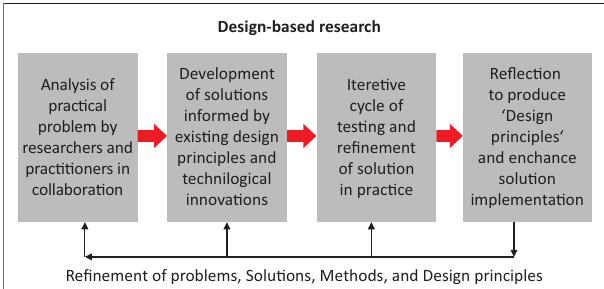
FIGURE 2: Design-based